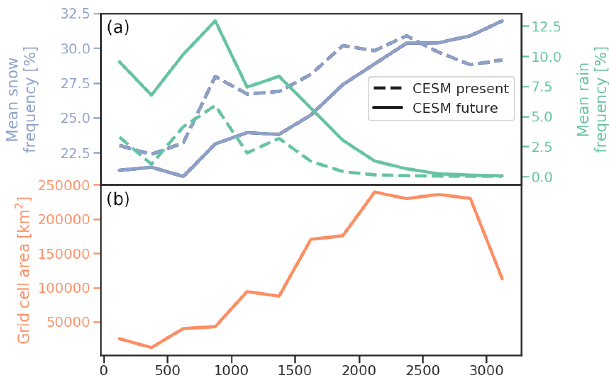
Figure 11. (a) Future (2080–2095) (solid) and present (2006–2020) (dashed) Greenland Ice Sheet snow (blue) and rain (green) fre- quency in 250m elevation bins based on GIMP topography, as sim- ulated by CESM. (b) Total ice sheet surface area in each of these elevation bins according to